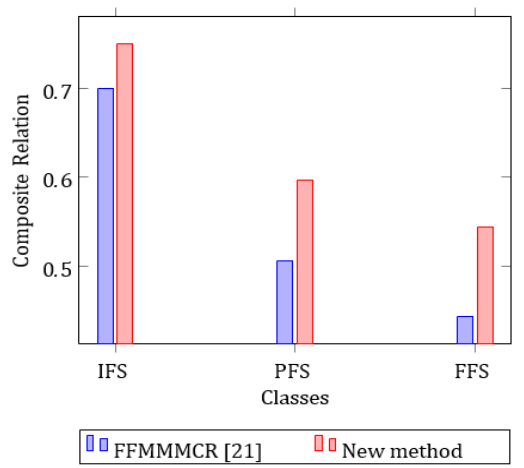
Fig. 1. Graphical representation of composite relations in terms of IFS, PFS, FFS.